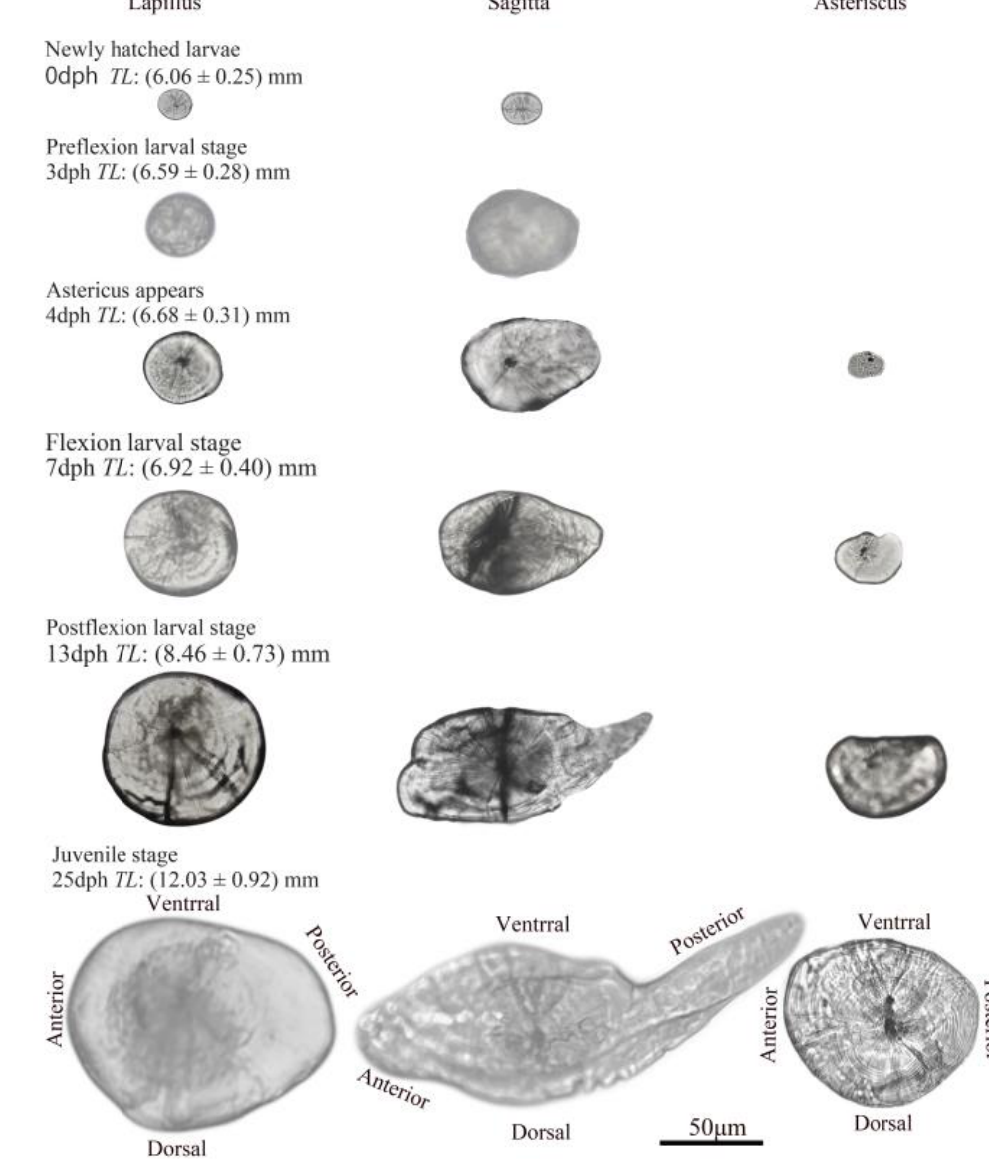
Figure 2. Otolith development in Sinogastromyzon wui .